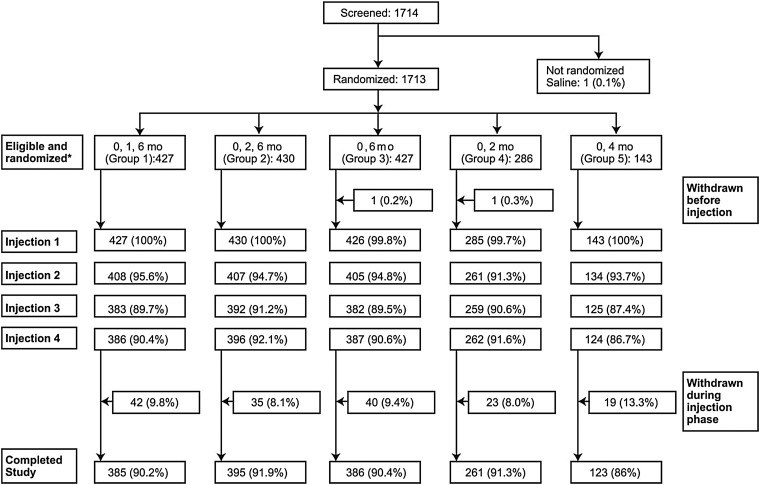
Subject disposition. *Values in this row used as denominators for percentages.